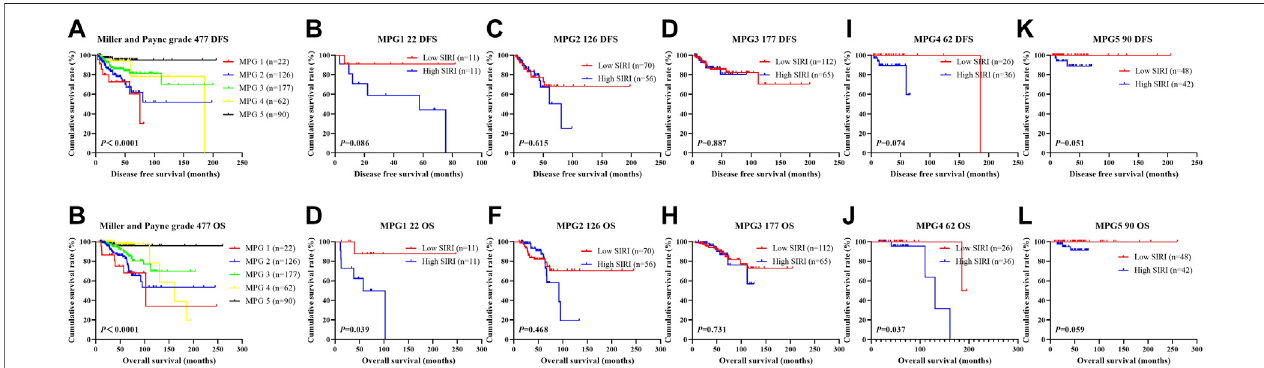
FIGURE 9 | DFS and OS based on Miller and Payne grade (MPG) in breast cancer patients who received NACT. (A) Kaplan-Meier analysis of DFS based on MPG for the SIRI of patients with breast cancer. (B) Kaplan-Meier analysisofOSbasedonMPGfortheSIRIofpatientswithbreastcancer. (C) Kaplan-MeieranalysisofDFSbasedonMPG1fortheSIRIofpatientswithbreastcancer. (D) Kaplan-MeieranalysisofOSbasedonMPG1fortheSIRIofpatientswithbreastcancer. (E) Kaplan-MeieranalysisofDFSfortheSIRIofpatientswithbreastcancer (MPG2). (F) Kaplan-Meier analysis of OS for the SIRI of patients with breast cancer (MPG2). (G) Kaplan-Meier analysis of DFS for the SIRI of patients with breast cancer (MPG3). (H) Kaplan-Meier analysis of OS for the SIRI of patients with breast cancer (MPG3). (I) Kaplan-Meier analysis of DFS for the SIRI of patients with breast cancer (MPG4). (J) Kaplan-Meier analysis of OS for the SIRI of patients with breast cancer (MPG4). (K) Kaplan-Meier analysis of DFS for the SIRI of patients with breast cancer (MPG5). (L) Kaplan-Meier analysis of OS for the SIRI of patients with breast cancer (MPG5).